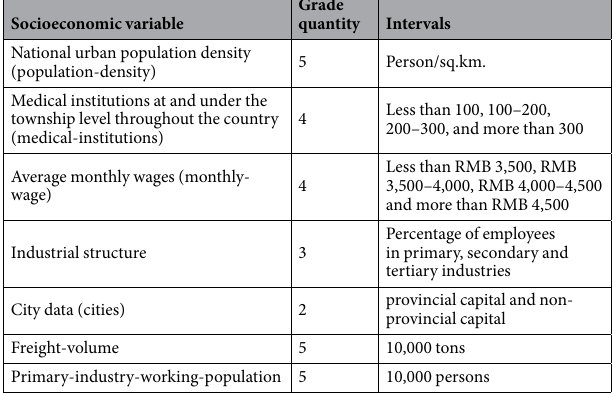
Table 1. Division grade corresponding to each social variable.